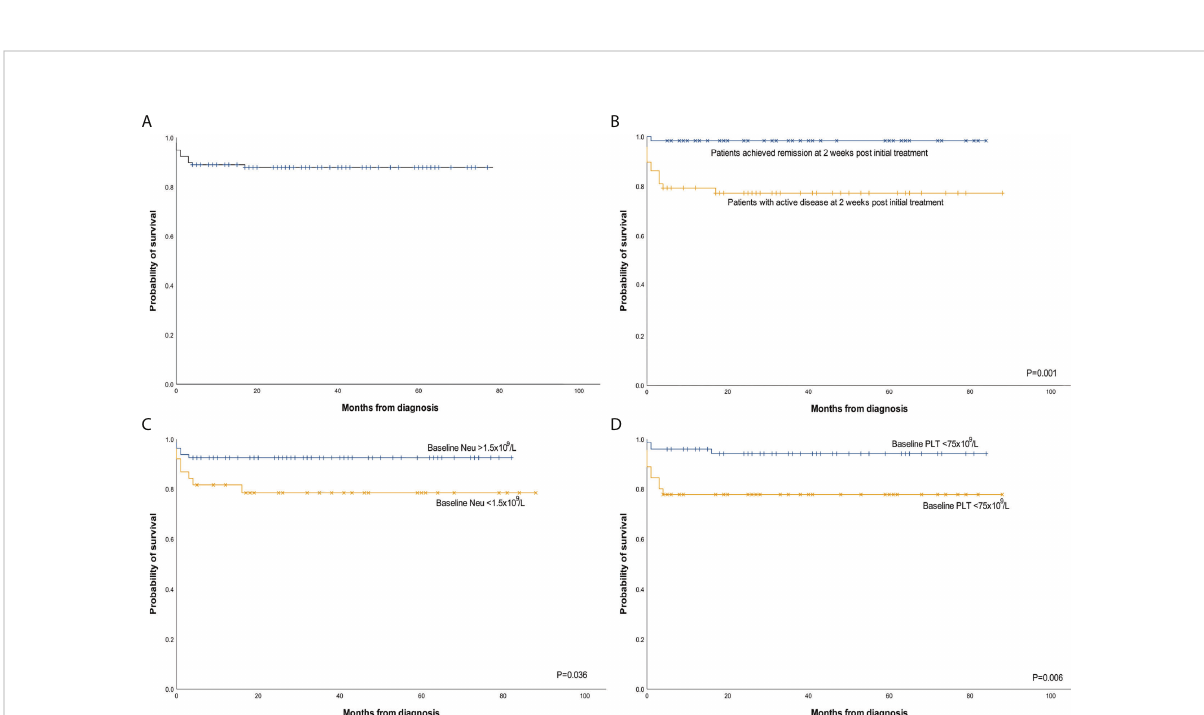
FIGURE 4 Kaplan – Meier survival curves. (A) Overall survival (OS) for the entire cohort (n = 118). (B) OS by the MAS status at the 2-week post initial treatment (P = 0.001). (C) OS by the baseline Neu level (P = 0.036). (D) OS by the baseline PLT level (P = 0.006). MAS, macrophage activation syndrome; Neu, neutrophil count; PLT, platelet